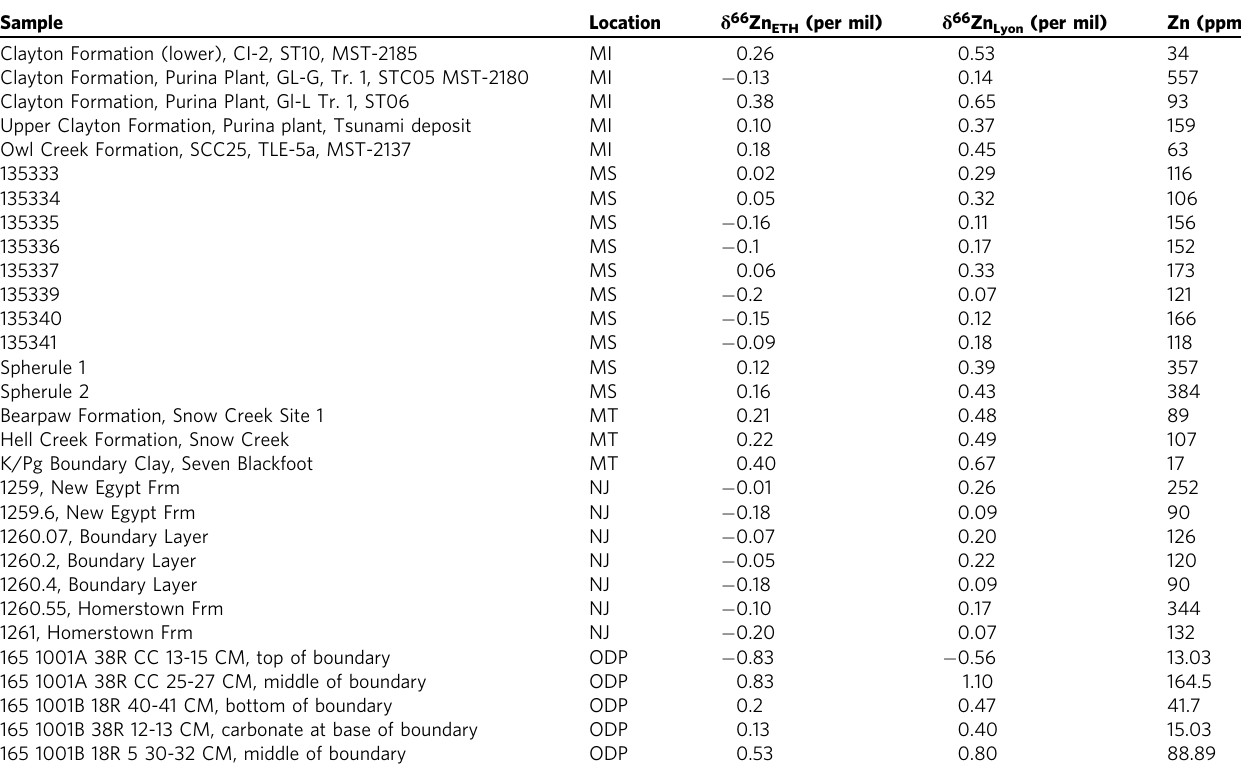
Table 1 Zn isotope and concentration data from K – Pg sedimentary sites. Sample